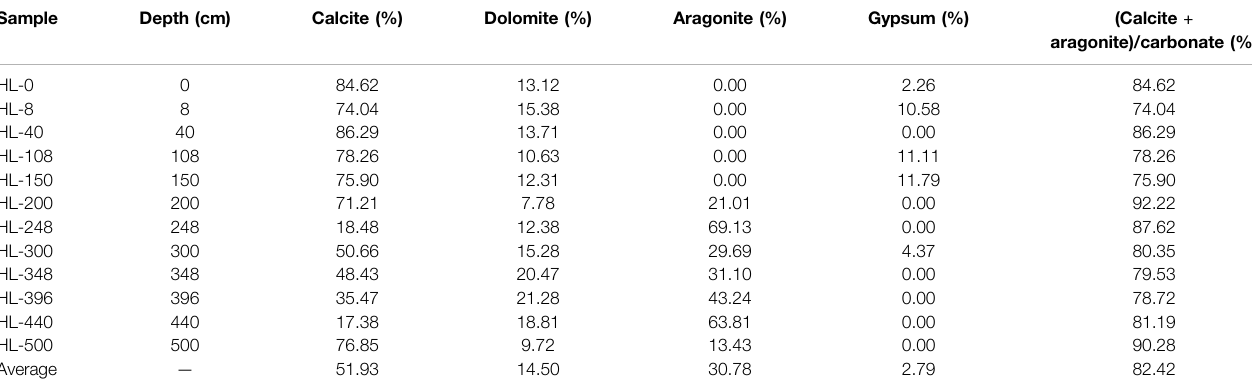
TABLE 2 | Component of fi ne-grain carbonate evaluated by the XRD method of the HL18-3 core. Sample Depth